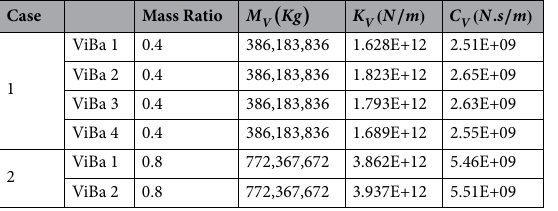
Table 1. Design parameters of each ViBa unit for Case 1 and Case 2 obtained from optimization procedure. For multiple masses in the same excavation, the total mass can be split accordingly.